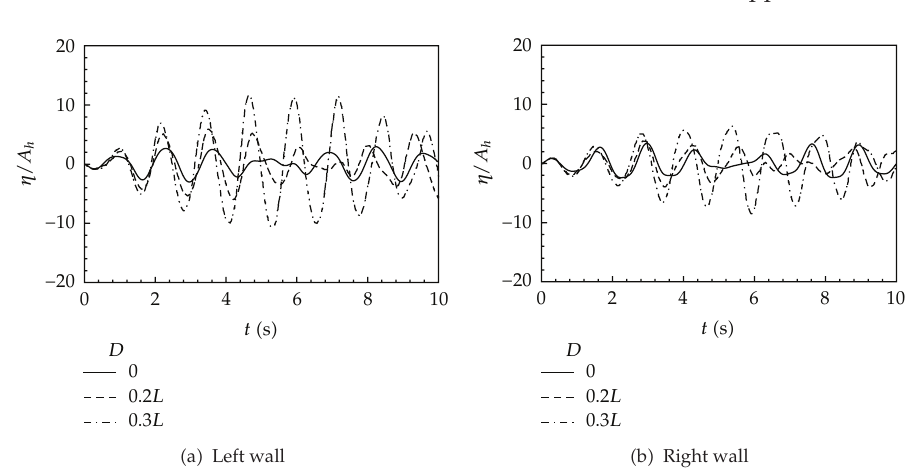
Figure 15: Time histories of wave surface at the left and right walls for Hb (cid:8) 0 . 8 H .